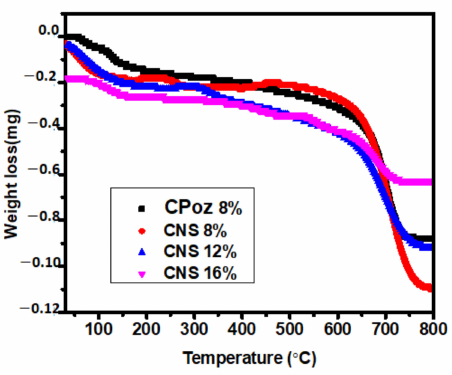
Figure 12. TGA analysis of portland composite cement based on pozzolan Napa soil on day